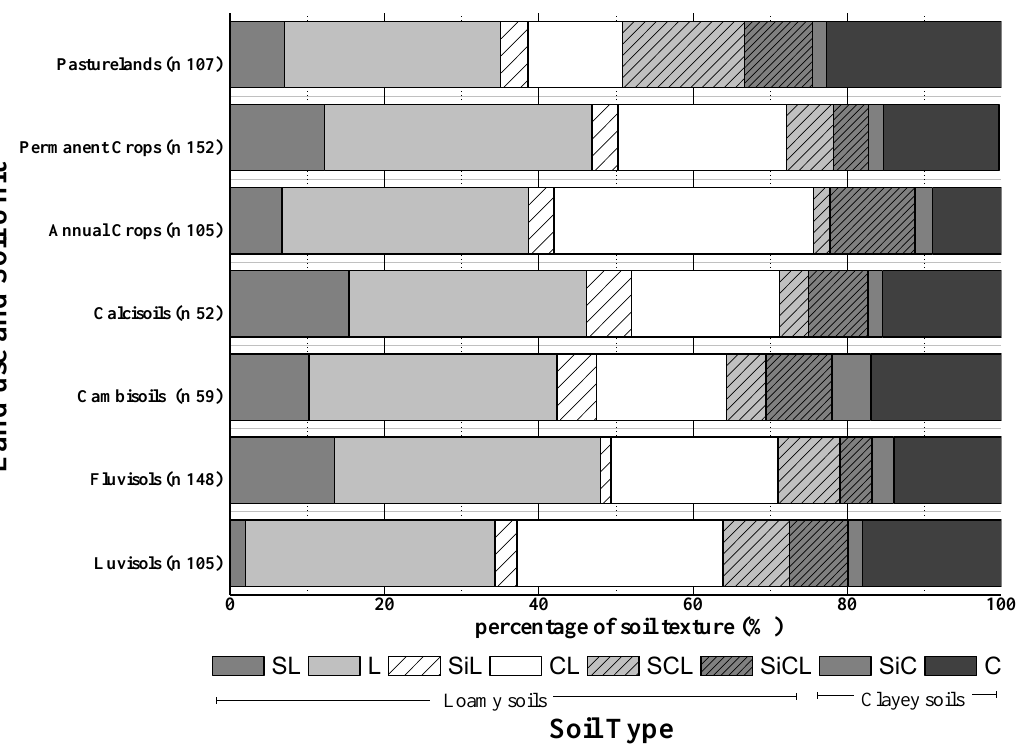
Figure 3. Different land use (LU), soil unit (SU), and soil type (ST) in study area. Principal component analysis (PCA) was used to identify the most appropriate soil indicators (a minimum data set MDS) that reflect soil function from a large (17) data set of soil properties. A minimum data set (MDS) of these indicators could provide us with accurate and up to date information about the soil variability of fields in the study area, which can be used as a decision support tool for agriculture management